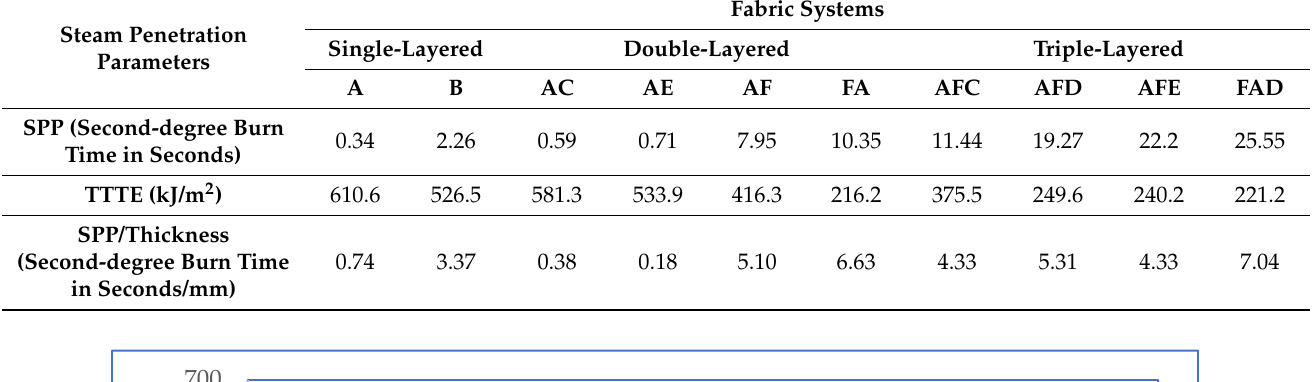
Table 3. Steam penetration parameters of fabric systems. Table 4. Flame and radiant heat protective performance of selected fabric systems [adopted from Mandal, et al. (2013)] [7].